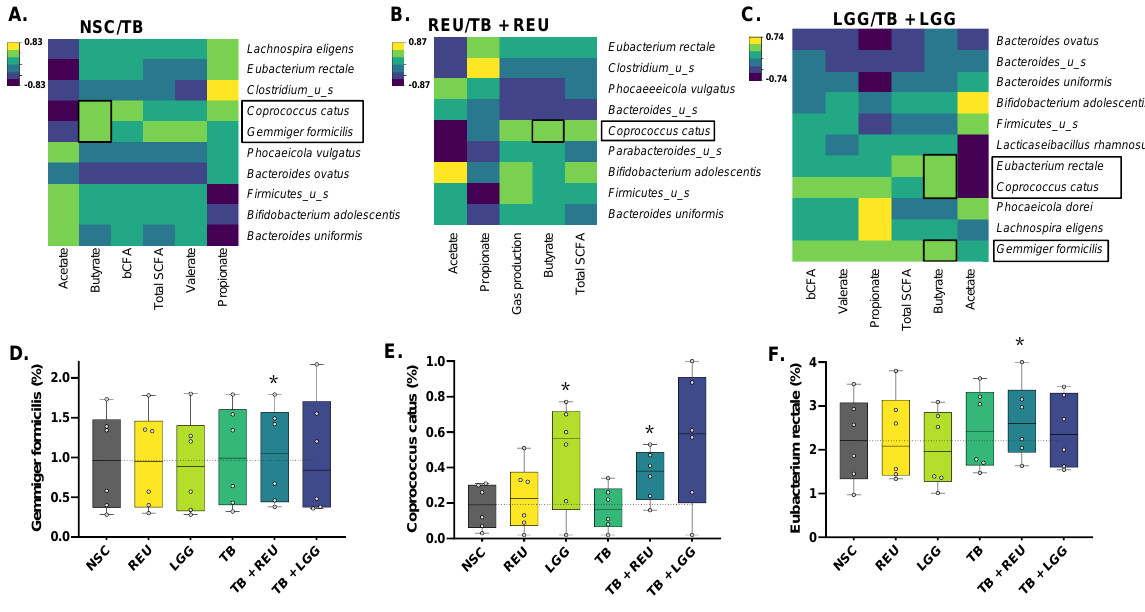
Figure 6. Regularized Canonical Correlation Analysis (rCCA) highlights correlations between butyrate and compositional data at the species level , focusing on ( A ) TB-treated samples, ( B ) REU- treated samples (with and without TB), and ( C ) LGG-treated samples (with and without TB). Bar plots of relative abundance of the three selected species involved in butyrate production according to the rCCA ( D – F ), across simulations for six healthy donors (n = 6). Statistically significant differences (FDR = 0.20) compared to the NSC is marked with an